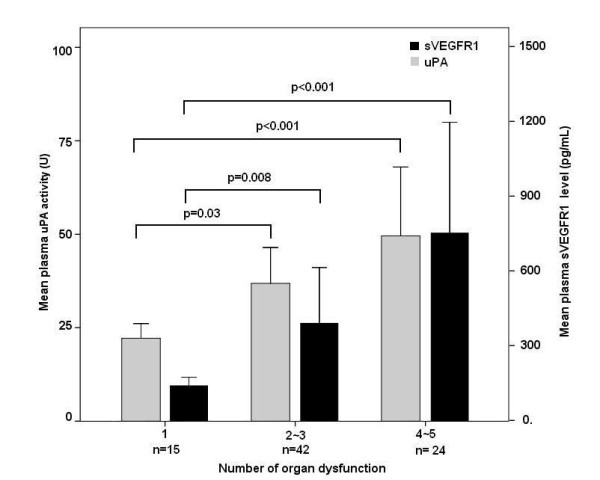
Plasma soluble vascular endothelial growth factor receptor 1 (sVEGFR1) levels and urokinase plasminogen activator (uPA) activities in pneumonia-related septic shock patients with various numbers of organ dysfunctions. Means and standard errors of the mean of the sVEGFR1 levels (solid bars) and uPA activities (shaded bars) are shown. Significance was tested with the two-sided Mann-Whitney U test.